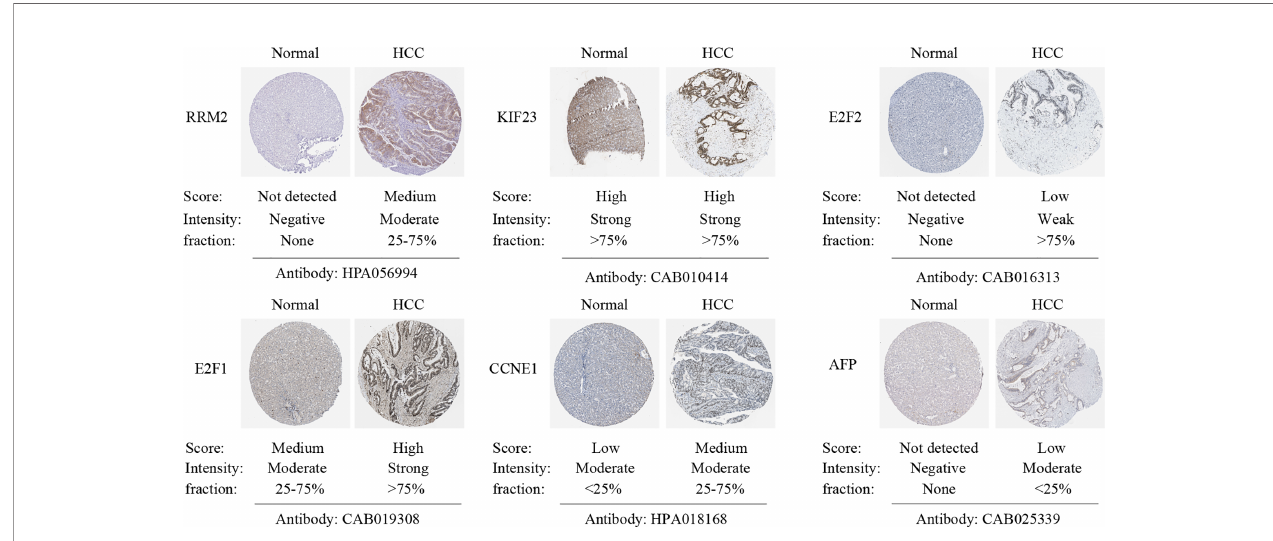
FIGURE 9 | Veri fi cation of hub genes protein expression in HCC and normal liver tissues. Immunohistochemistry images of hub genes and AFP in HCC and normal liver tissues based on Human Protein Atlas (HPA). The expression score is categorized into high, medium, low, and not detected. The expression score re fl ects the protein level of the gene in this specimen.